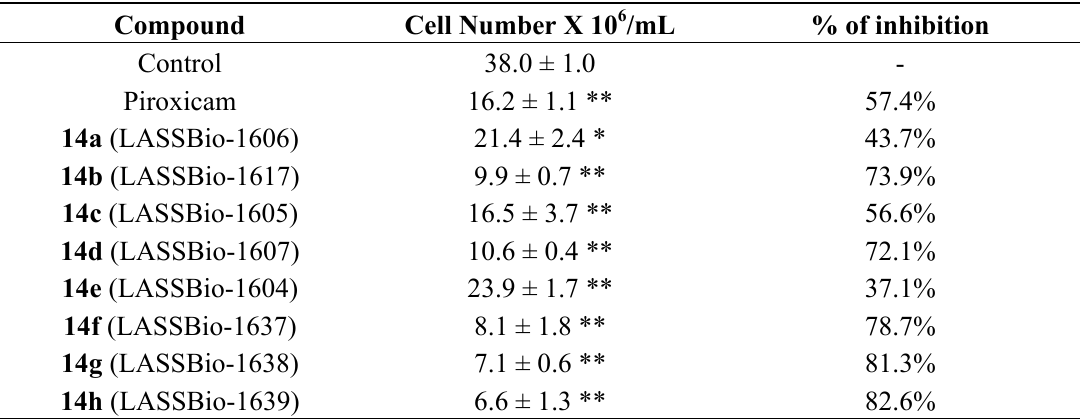
Table 4. Effect of piroxicam NAH analogues and piroxicam (100 µmol/kg, p.o.) on zymosan-induced peritonitis in mice.